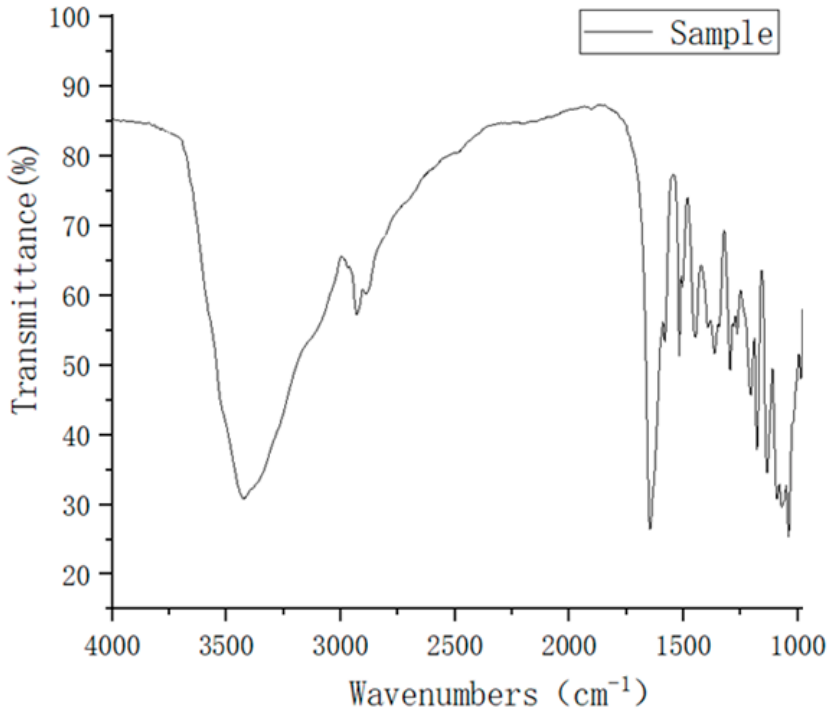
Figure 6. Fourier transform infrared spectrum of naringin.